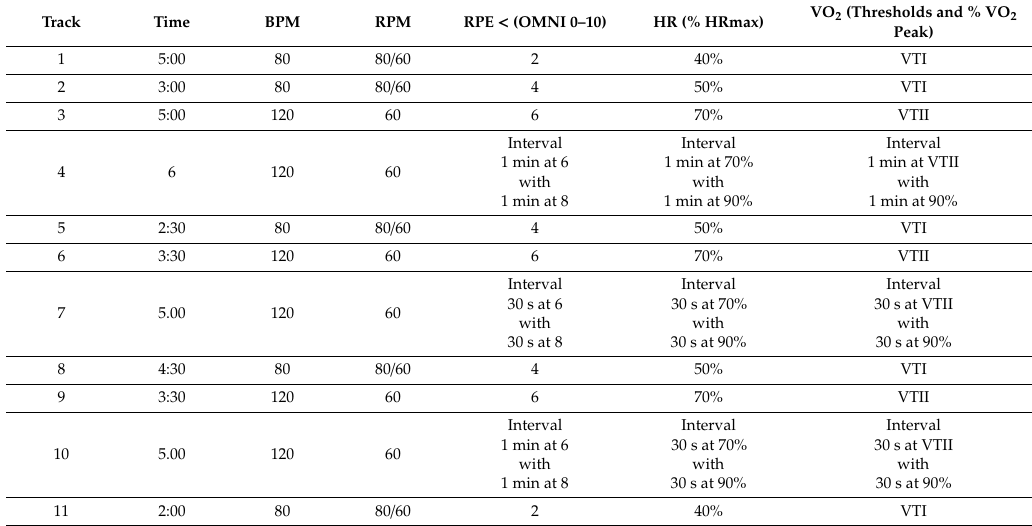
Table 1. Planning of the 45 min of indoor cycling in the three